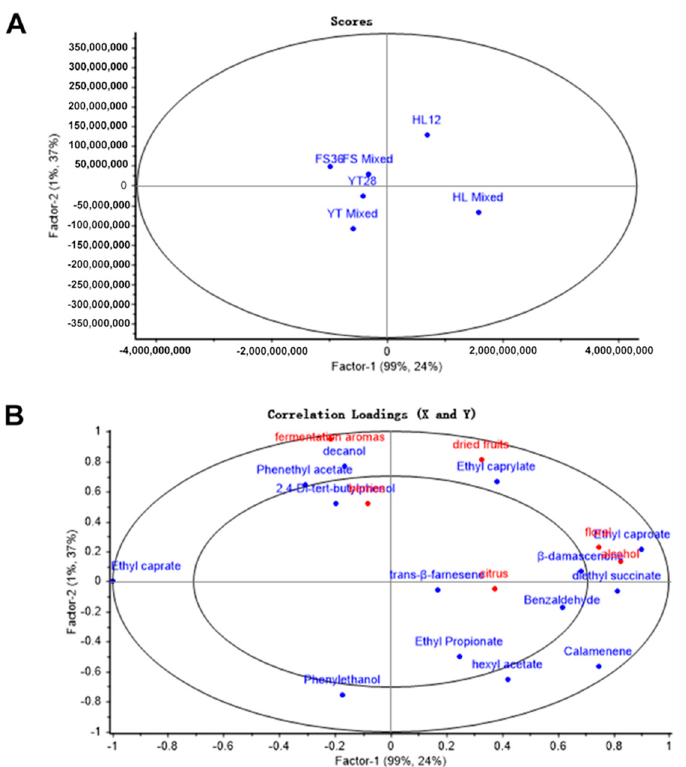
Figure 5. Partial least square regression correlation plot for six Marselan wines. The model was established by 14 key aroma compounds of GC-MS measurements as X, Y for the flavor attributes. ( A ) Scores of samples; ( B ) correlation loadings of X and Y.